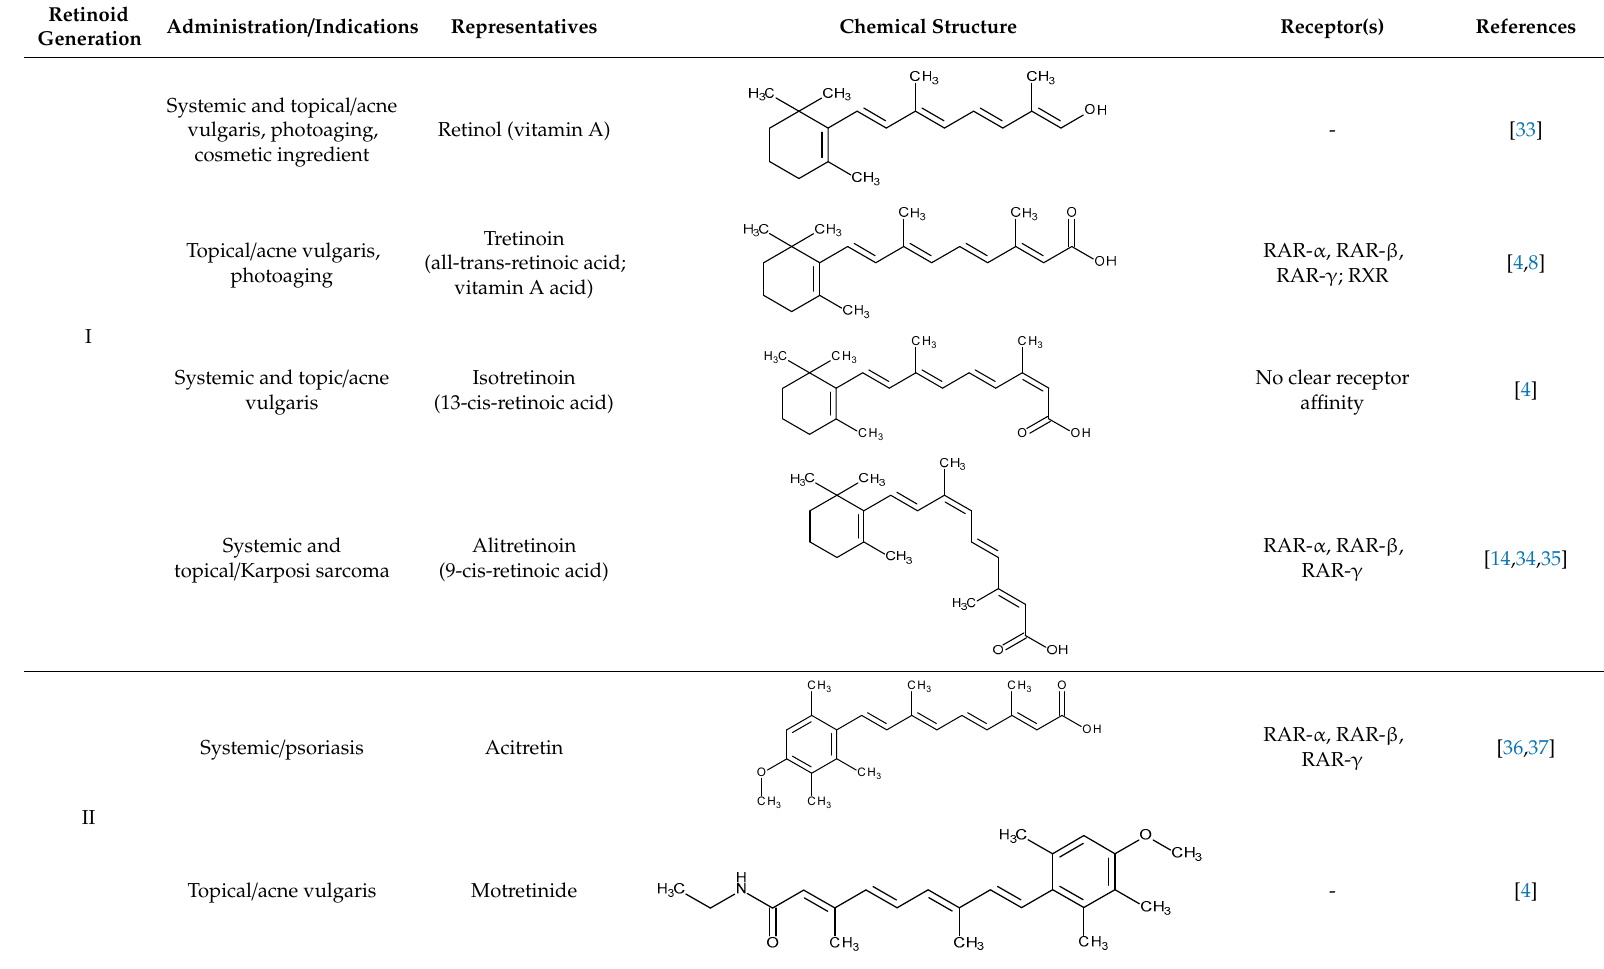
Table 1. Classification of retinoids by generations.